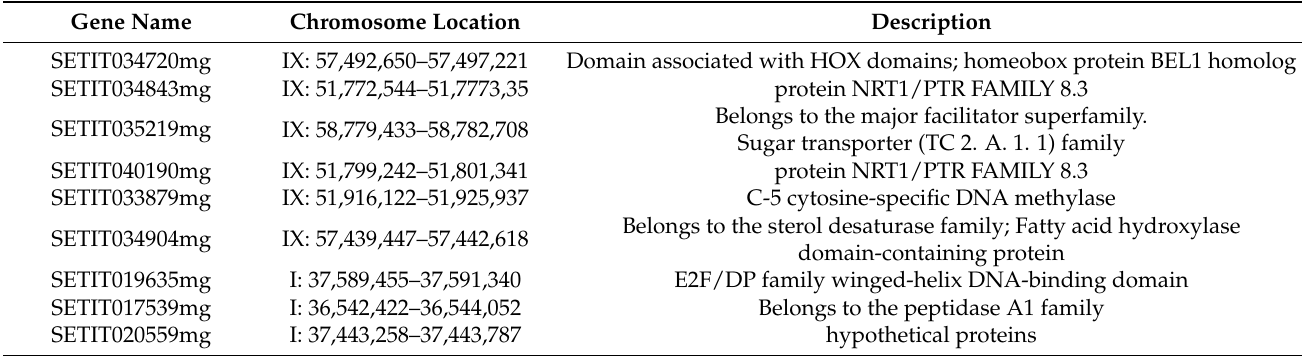
Table 3. Basic information of candidate